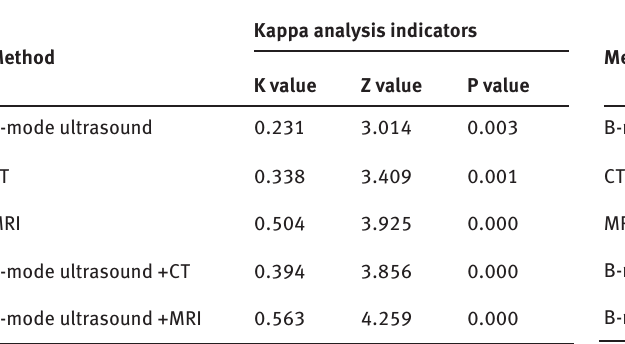
Table 4: Consistency of B-mode ultrasound, CT and MRI Examina- tions in Estimating Myometrial Infiltration